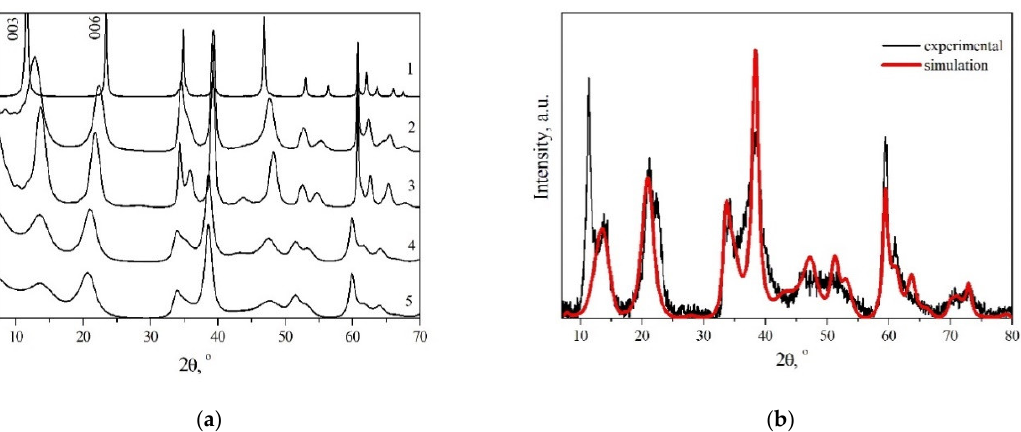
Figure 9. Simulation of XRD patterns with different lamella thicknesses ( a ): (1) model of pure 3R 1 polytype; (2) L h = 2.0 nm, L b = 0.5 nm; (3) L h = 1.1 nm, L b = 0.5 nm; (4) L h = 1.1 nm, L b = 0.7 nm; (5) L h =